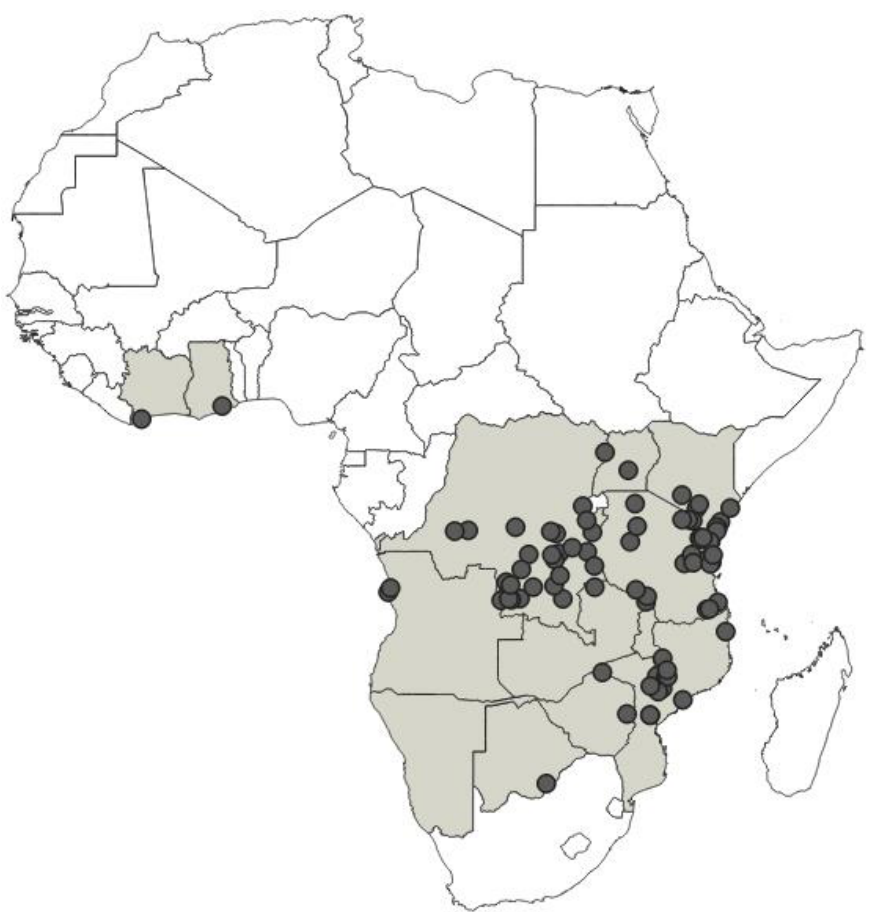
Figure 56. Known distribution of Phonoctonus picturatus Fairmaire, 1858.